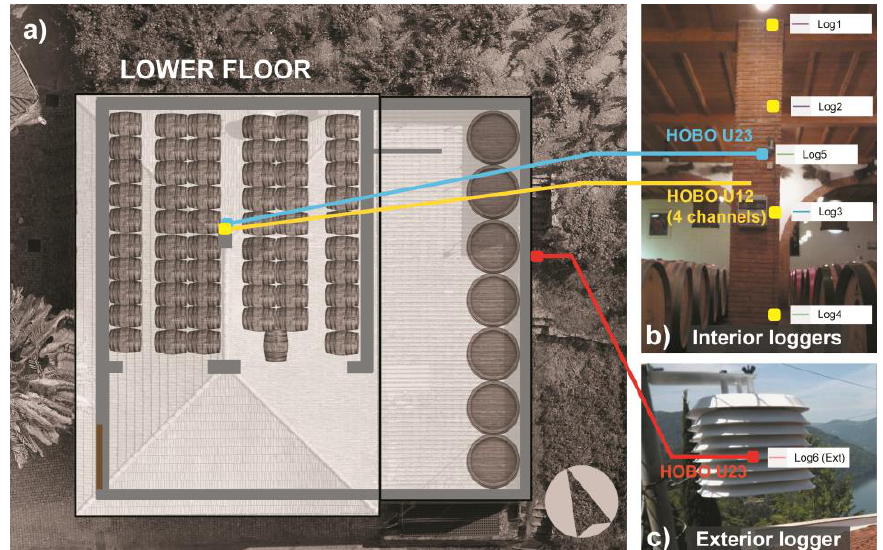
Figure 2 . Distribution inside the cellar of the ( a ) logger positions and images of the ( b ) indoor loggers installed in the wall and ( c ) the outdoor logger.